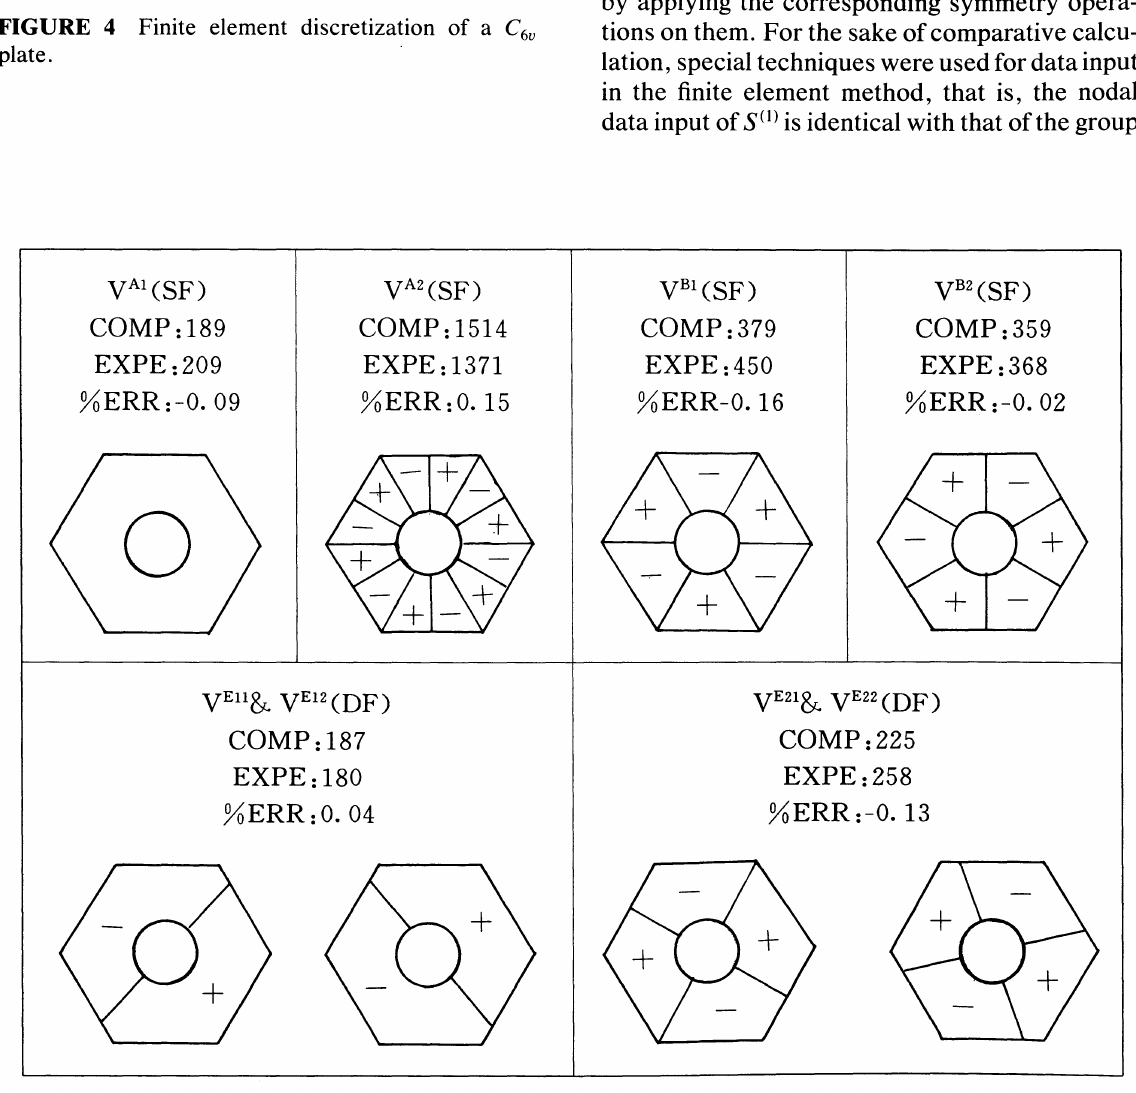
FIGURE 5 First-order frequency and modal shape in each subspace. SF, single frequency; DF, duplicated frequency; COMP, computational result; EXPE, experimental result; and ERR,